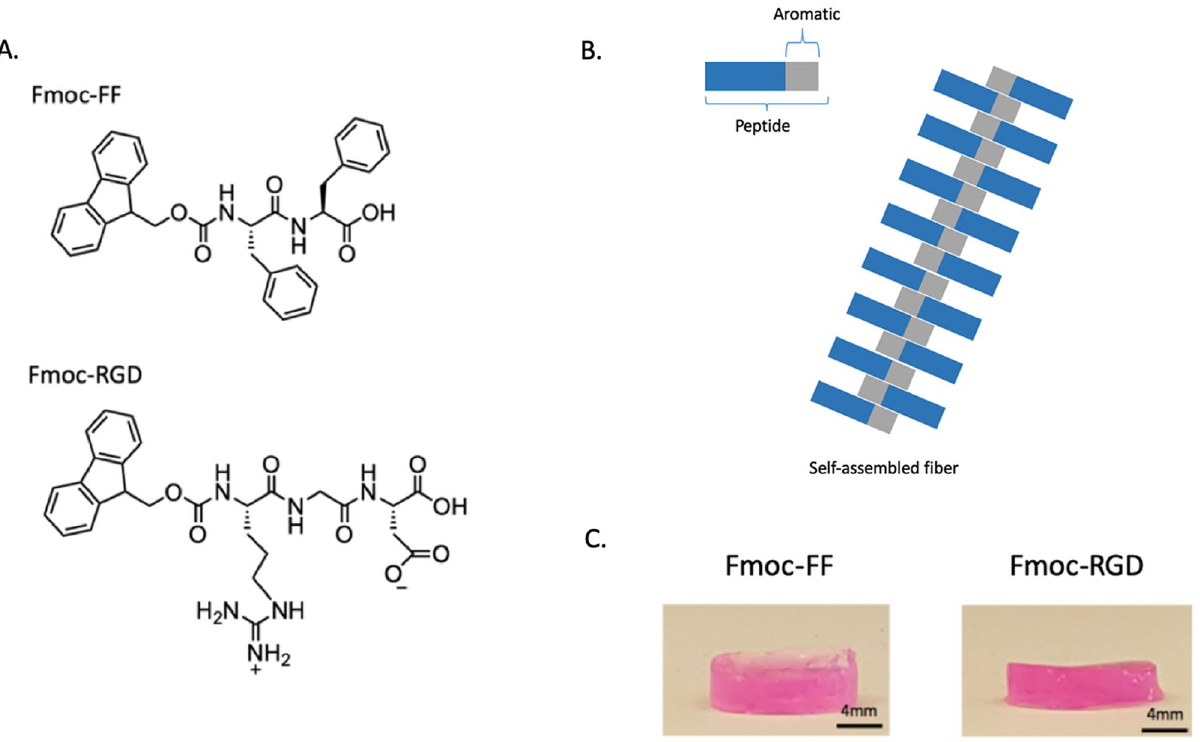
Figure 1. Actin-DAPI staining of primary hepatocyte aggregates cultured in Fmoc-FF/RGD ( A ) Fmoc-FF ( B ) and Matrigel ( C ) hydrogels (scale bars- 50 μm) and assessed for ( D ) cell viability and cytotoxicity. PowerPoint Professional Plus 2013 and Graphpad Version 6.0 was used to make the figure. Structures of the peptides Fmoc-FF and Fmoc-RGD ( A ). Proposed model of peptide fiber assembly adapted from Zhou 27 ( B ) and 300 μl Fmoc-FF and Fmoc-FF/RGD hydrogel constructs ( C ). Powerpoint Professional Plus 2013 was used to make the